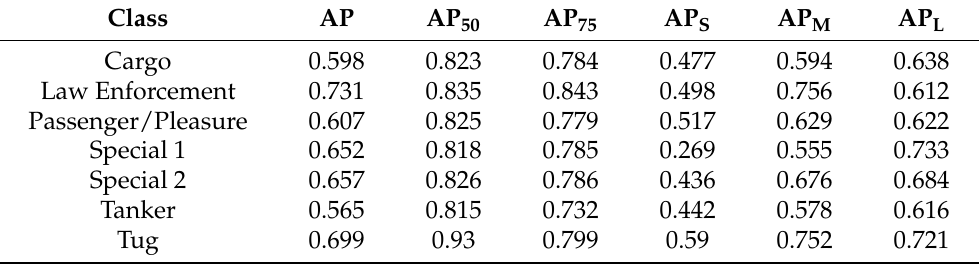
Table A6. Resulting instance segmentation APs per class of the ShipSG dataset using Centermask- Lite V39 , as explained in Section